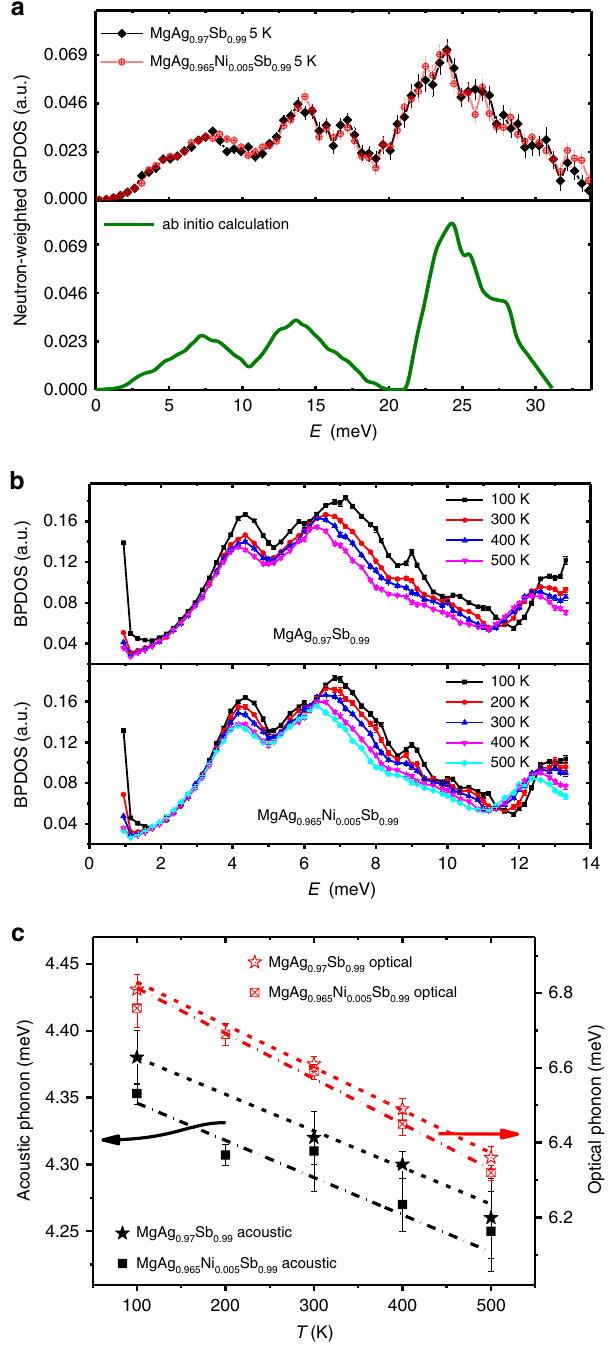
Phonon softening . Figure 4 shows the atomic dynamic properties in the MgAgSb-based thermoelectric materials, which are mea- sured by INS and calculated by ab initio calculations (see Methods section). Here, we demonstrate that the values of the generalized phonon density of states (GPDOS) of both α -MgAgSb, not only in terms of the total shape but also the energy of the main features, including the three main optical phonon peaks at ~8, 14, and 24 meV and the acoustic phonon shoulder peak at ~4.5 meV (Fig. 4a).